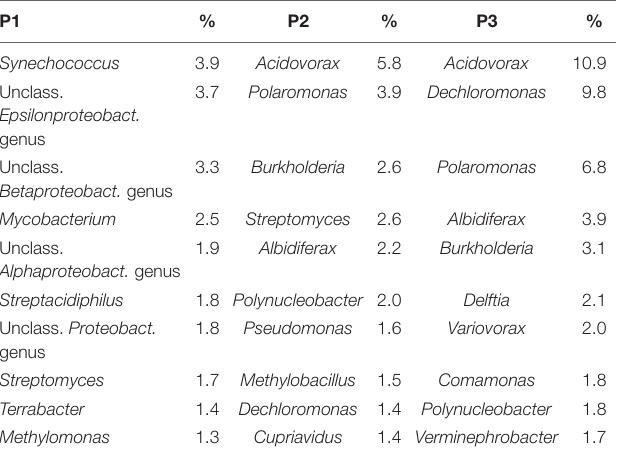
TABLE 2 | The relative abundance of the ten most abundant genera of bacteria in each